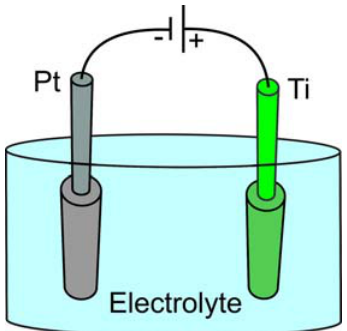
Figure 1. Schematic drawing of the electrochemical cell for the anodization. It is two-electrode system where the platinum is a counter electrode and the titanium is the are formed by the oxidation and etching of the metallic anode. The tubular arrays of TiO 2 titanium in the electrolyte. Anodization is carried under the voltage applied between the anode and the counter